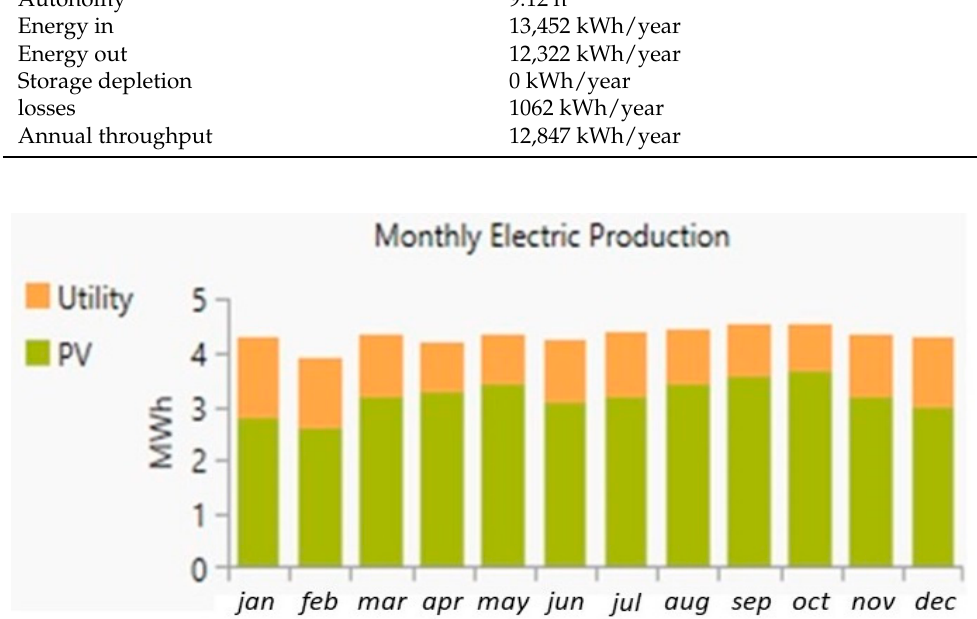
Figure 20. Monthly electric production for System 2.